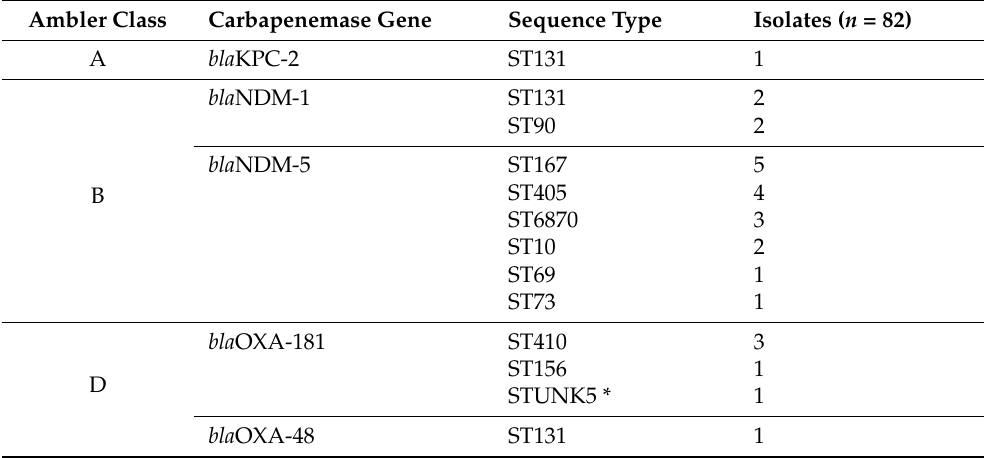
Table 2. Distribution and prevalence of the most common Ambler Class Carbapenemases by MLST from Alameda County, CA hospital patients from